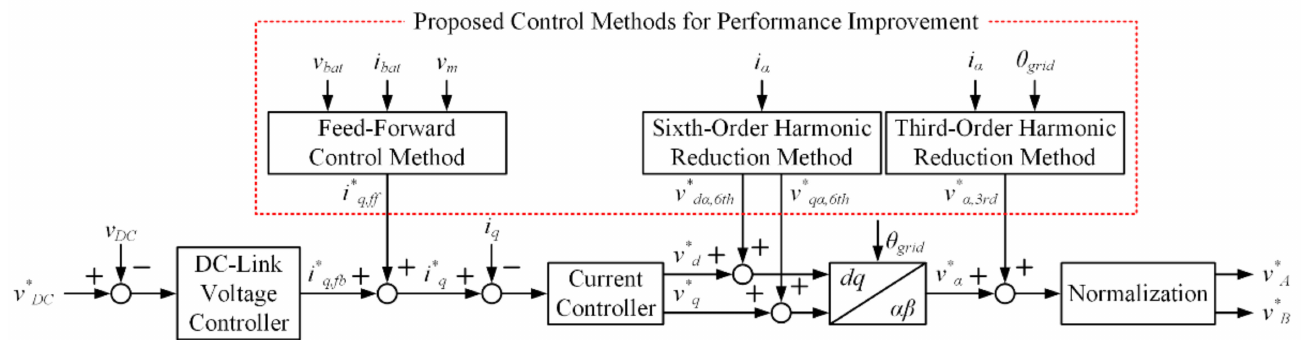
Figure 7. Control block diagram of the proposed control methods for performance improvement of integrated